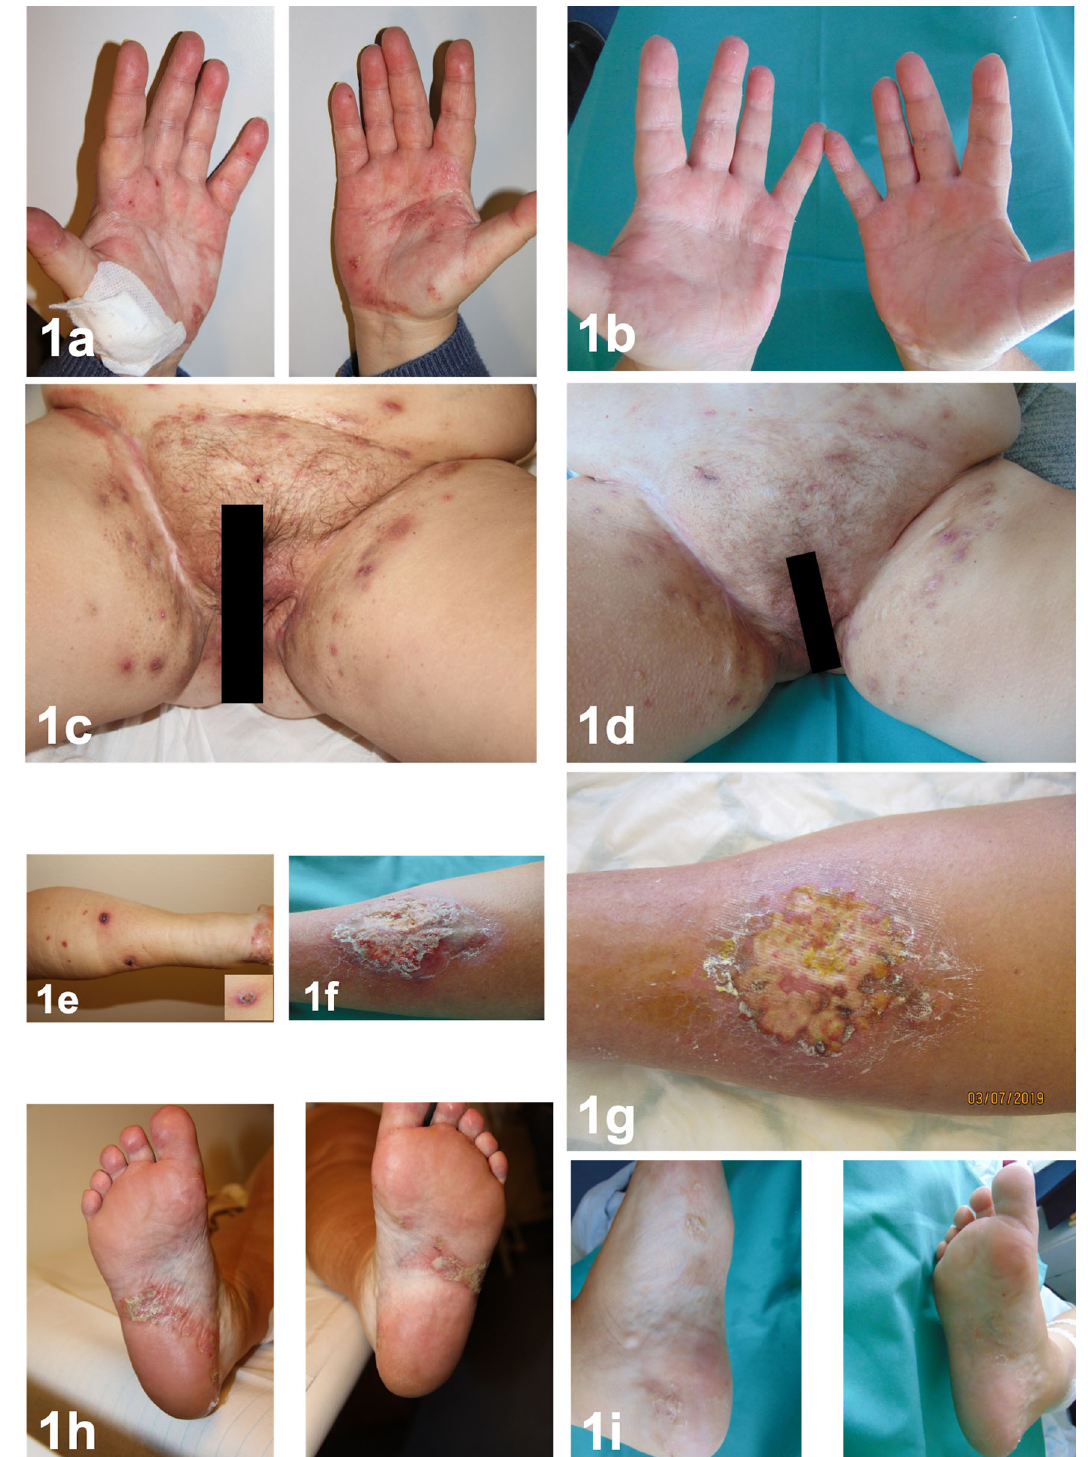
Figure 1. palmar psoriasis before (1a) and after (1b) treatment with secukinumab over 4 months. Manifesta- tions of HS localized in the inguinofemoral region before (1c) and after (1d) treatment. Pyoderma gangrenosum two months after adalimumab discontinuation (1e), clinical image 4 months after secukinumab treatment (1f) and post- prednisolone i.v pulse therapy (1g). Plantar pustulosis before (1h) and after secukinumab treatment (1i).